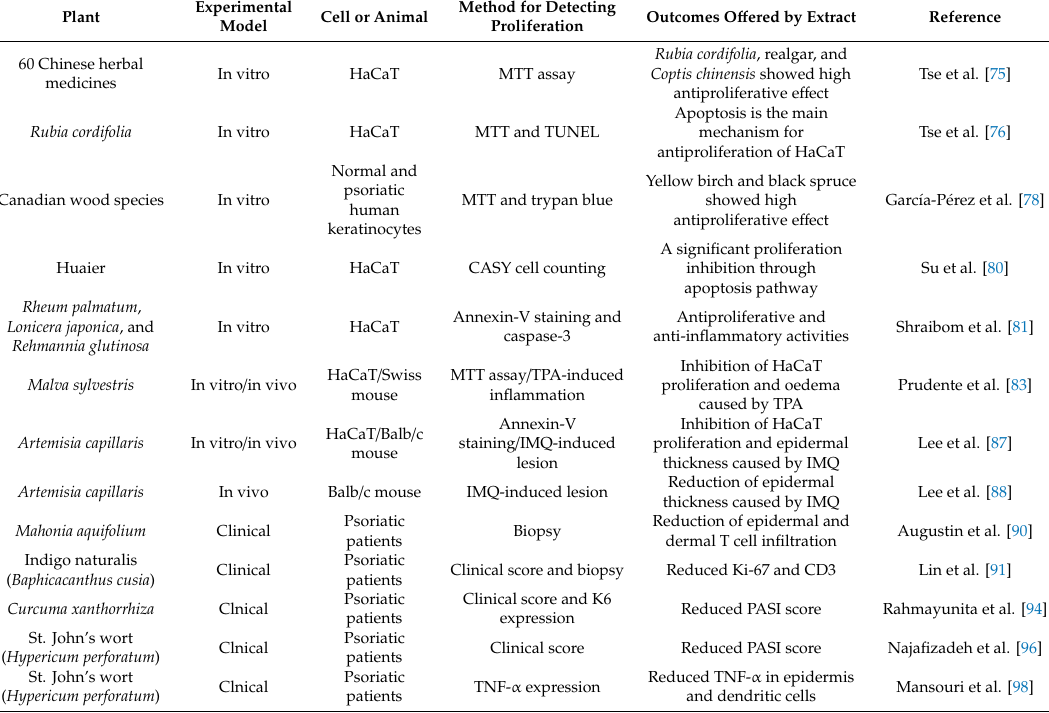
Table 2. Crude extracts derived from the plants for treating hyperproliferation of psoriasis.